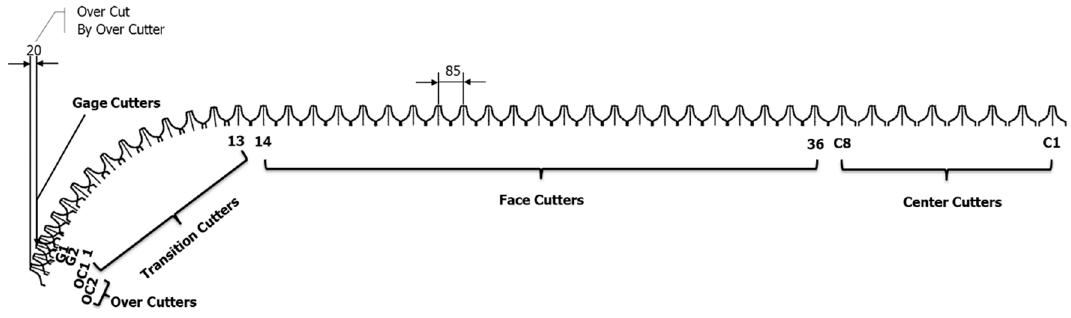
Figure 5. Disc cutter configurations of cutterhead.